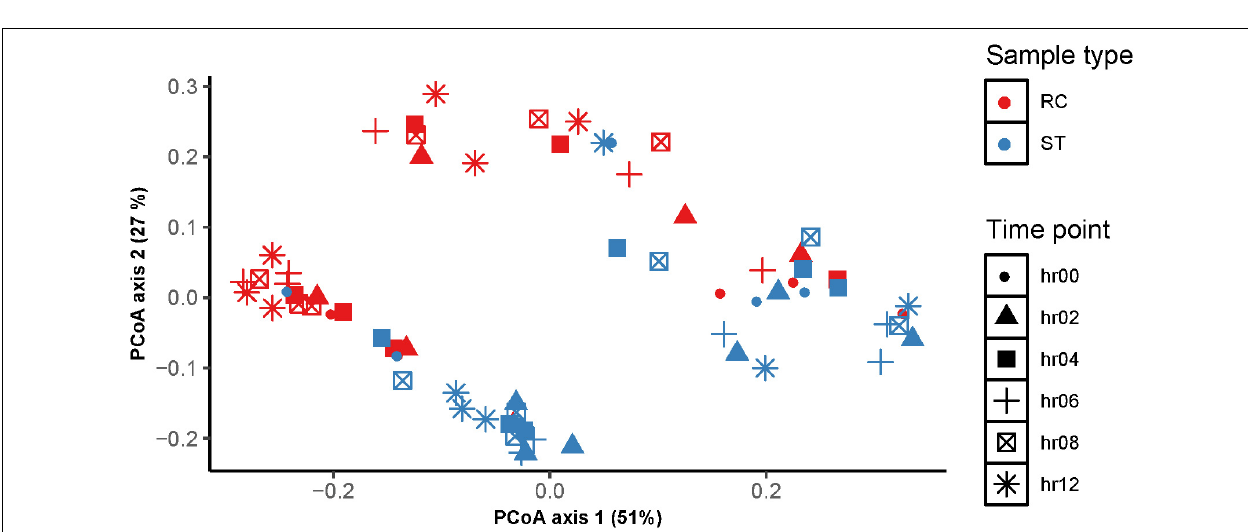
FIGURE 4 | Comparison of bacterial community composition of liquid fraction from samples collected using stomach tube (ST) and ruminal cannula (RC) at different sampling time [before feeding (hr00); 2 h after feeding (hr02), 4 h after feeding (hr04); 6 h after feeding (hr06); 8 h after feeding (hr08) and 12 h after feeding (hr12)]. The principal coordinate (PC) plots show weighted pairwise UniFrac distances between samples.